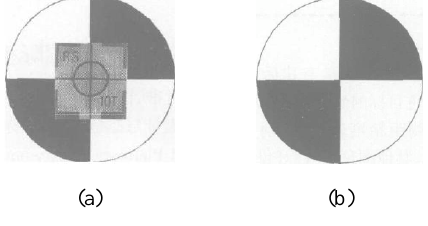
Figure1 reflection patch on HDS4500 targets Figure2 show sphere targets : the small reflected ball (Sphere targets of TCA2003 i.e.) is set on the same height with scan spheres, thus the scan target could be measured with high accuracy.